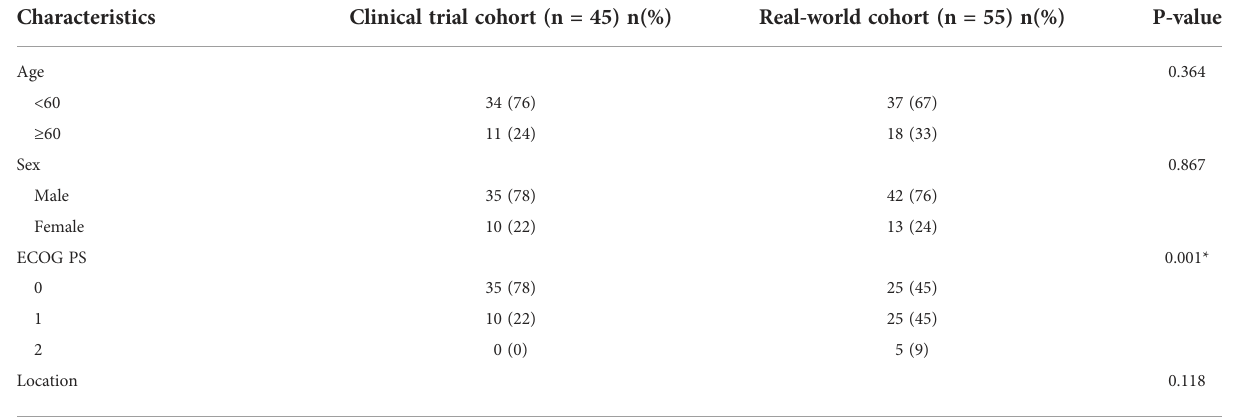
TABLE 1 Clinical characteristics of the clinical trial and real-world